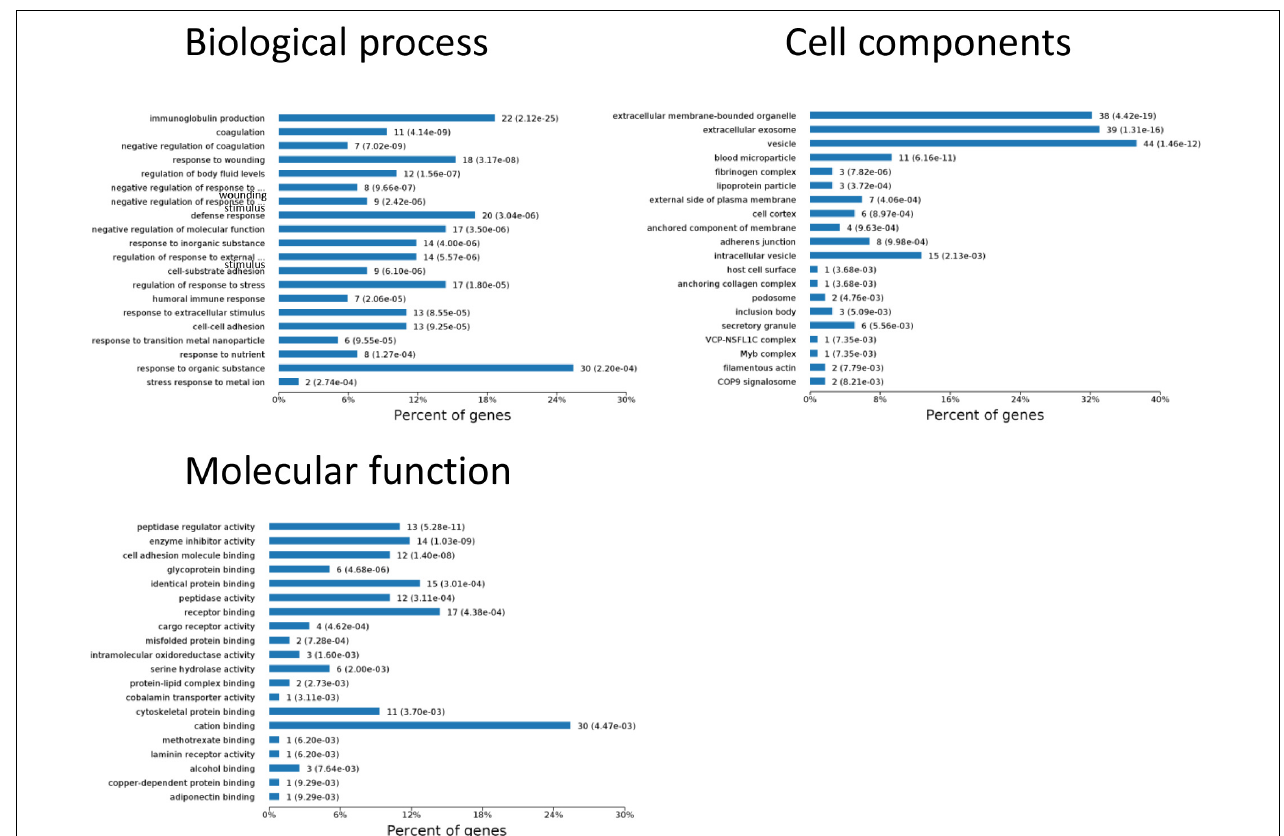
FIGURE 4 | Biological processes, cell components, and molecular functions in which differentially expressed proteins are involved. P <